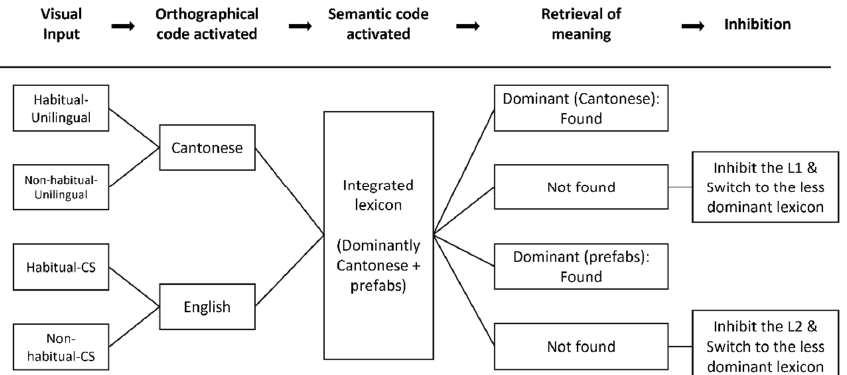
Figure 4. An illustration of the bilingual prefab’s processing model. The orthographic difference between the two languages in our study provides an early hint for language membership. As the sentence is primarily Cantonese, the default lexicon activated is the one with Cantonese as the dominant language. The Habitual-Unilingual and the Habitual-CS (as prefab) are retrieved from it. However, an inhibition of the dominant lexicon and the activation of the nondominant lexicon are needed to retrieve the Non-Habitual items.